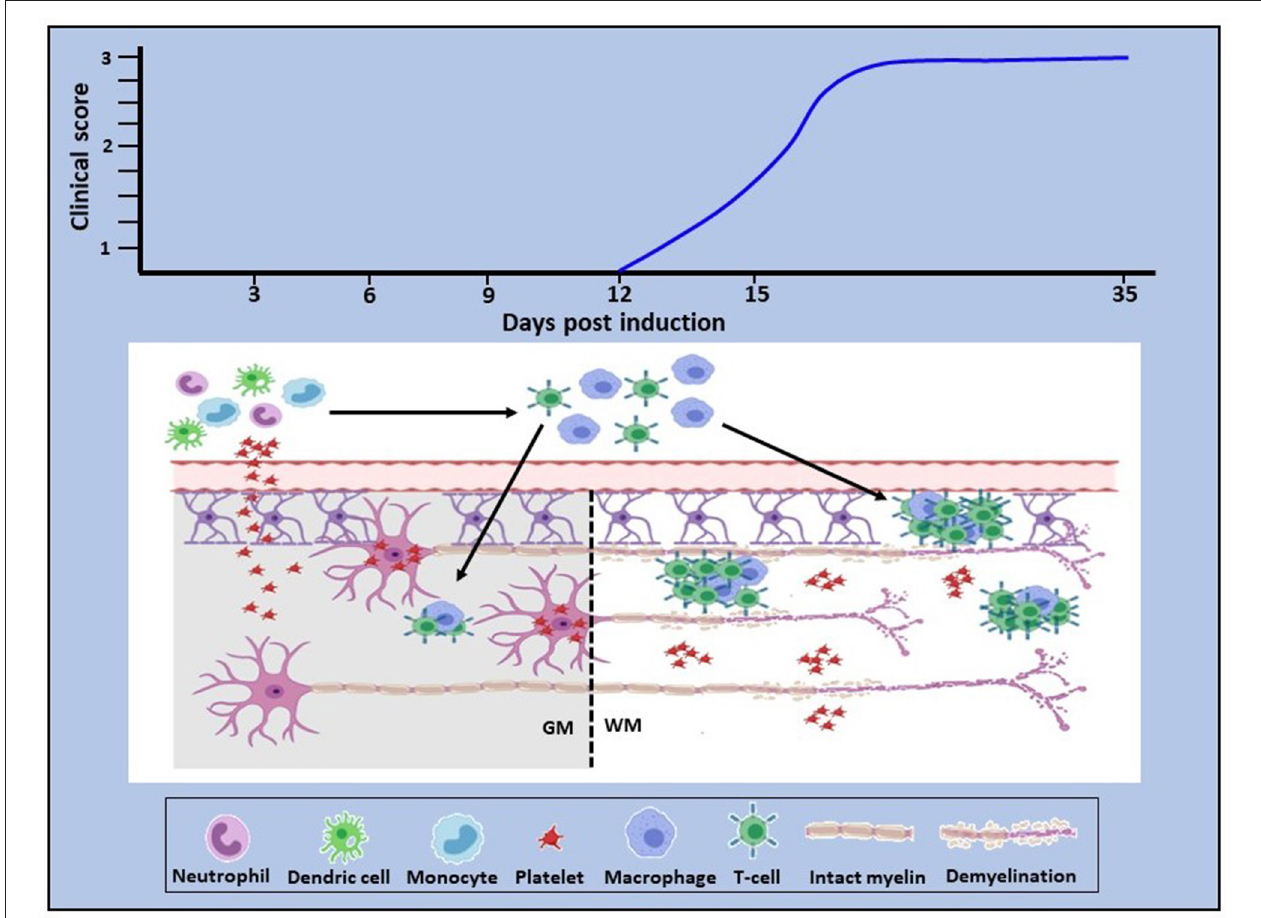
FIGURE 1 | Proposed role of platelets in neuroinflammation. In EAE, platelet activation is an early event which is quickly followed by platelet infiltration into the CNS white and gray matter. In white matter they disseminate throughout the parenchyma, whereas in gray matter they target neurons (bottom panel). Concurrently, platelets drive the generation of autoreactive immune cells which become detectable by day 11–12 post-disease induction, corresponding to clinical onset (top panel). This evidence provides proof of concept that platelets are neurodegenerative as well as pro-inflammatory and that these two pathological processes are causally linked. Additionally, these data suggest that platelet targeting would represent an effective anti-inflammatory and neuroprotective therapeutic approach for MS. GM, gray matter; WM, white